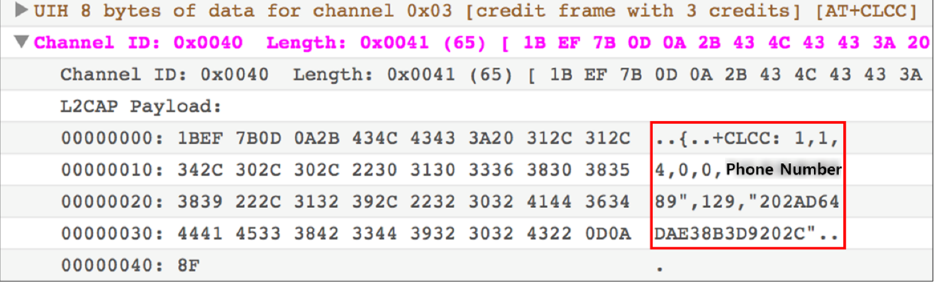
Figure 5. Phone number acquired in BT traffic (legacy system). From the red frame, the phone number and name saved in contacts are obtained.